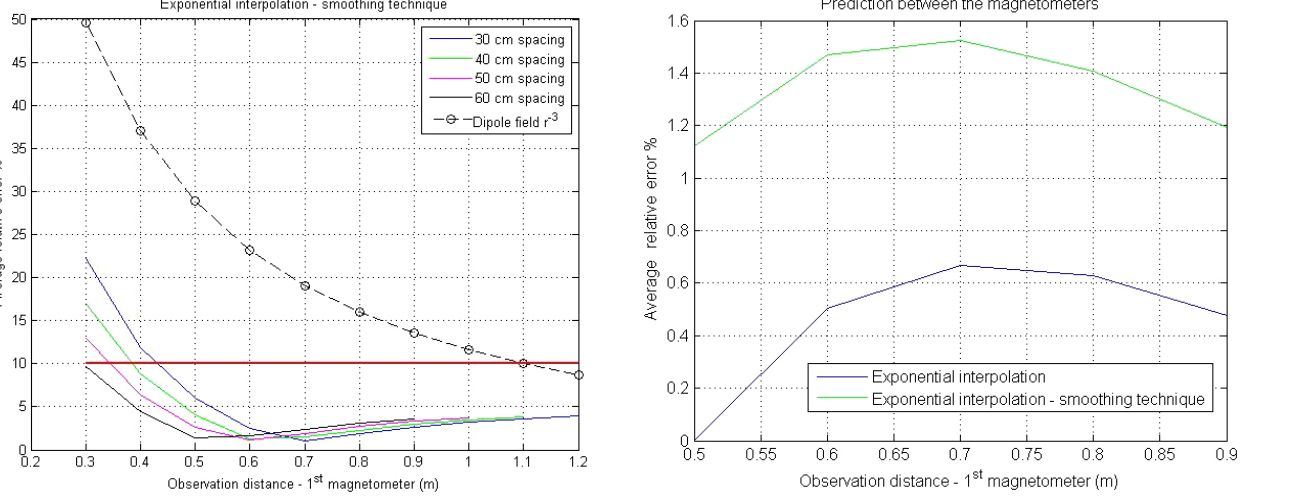
Figure 6. Magnetic field’s average relative error with respect to the first magnetometer’s position with fixed spacing 60cm between the